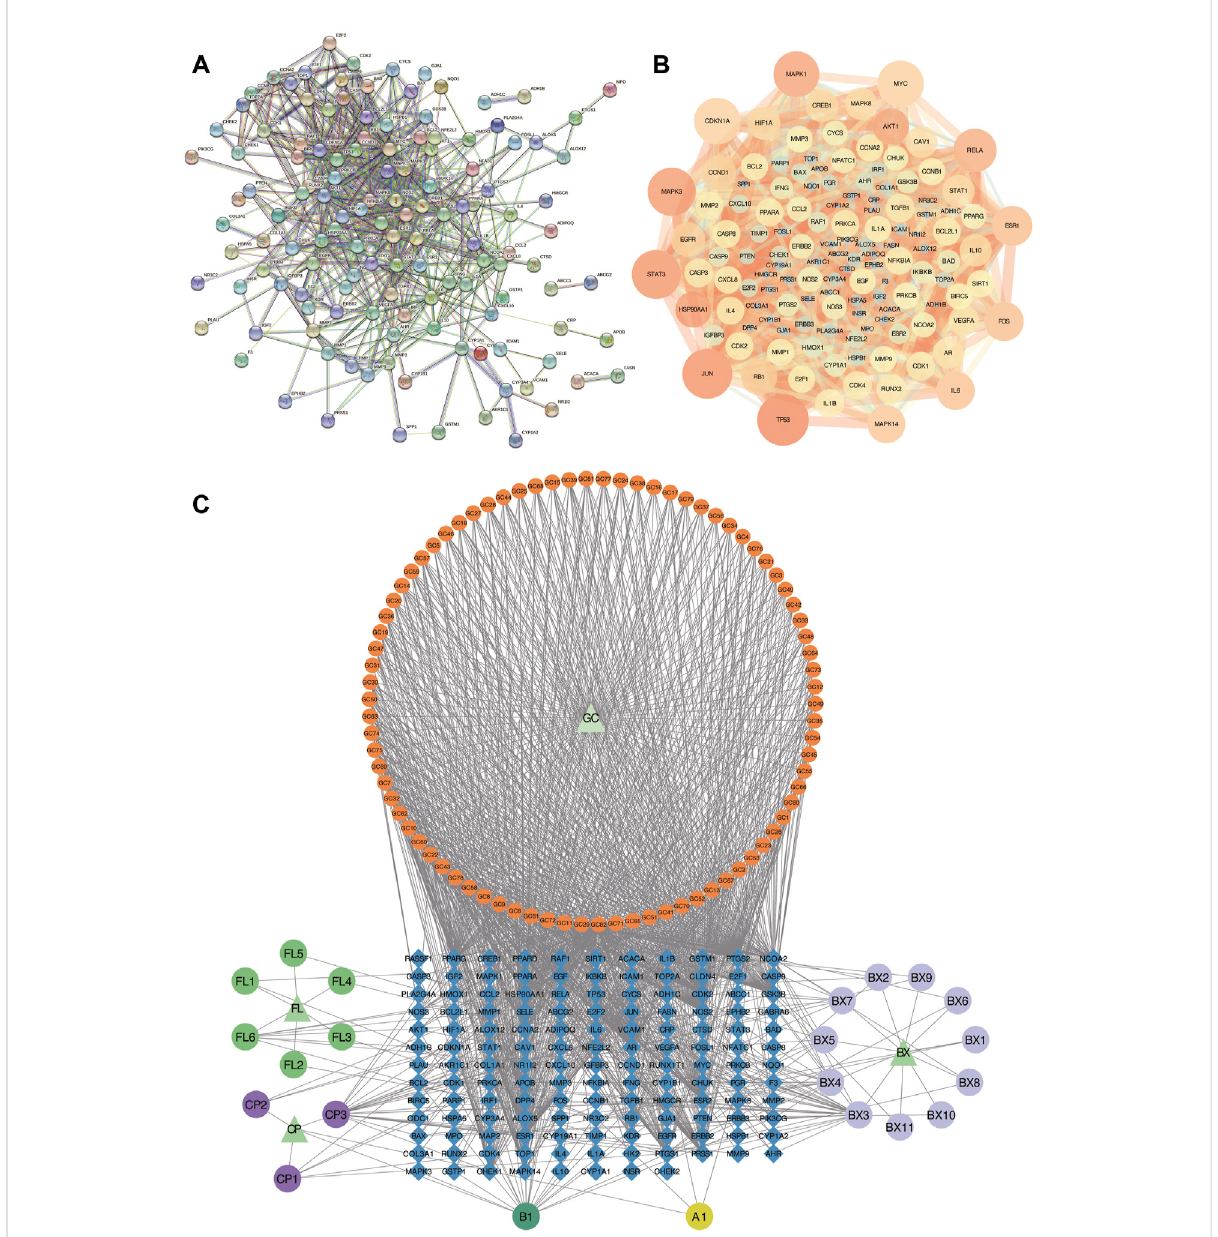
FIGURE 2 Analysis of PPI and Component-Target-Disease networks. (A,B) PPI Networks of the 140 intersective targets. (C) The component-Target- Disease network of herb components and CRC-related targets. GC: Glycyrrhiza glabra ; BX: Pinellia ternata ; FL: Poria cocos ; CP: Citrus reticulata